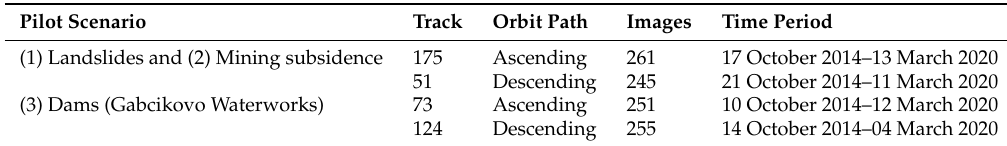
Table 1. Sentinel-1A/B datasets used.